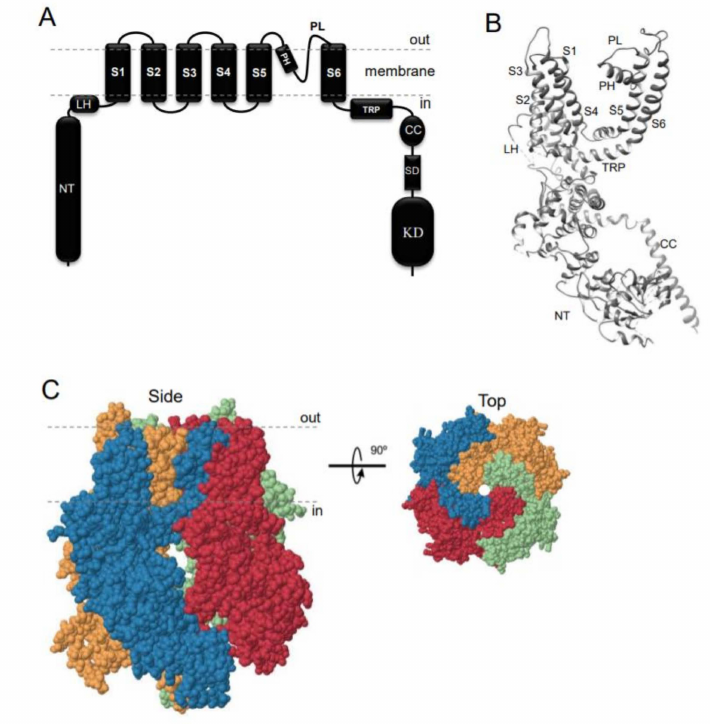
Figure 1. Domain topology and tetrameric assembly of the kinase-coupled channel TRPM7. ( A ) TRPM7 comprises a large cytosolic N-terminal domain (NT), a linker-helical domain (LH), six transmembrane helices (S1-S6), a pore-forming pore helix (PH) and loop (PL), a transient receptor potential domain (TRP), a coiled-coil domain (CC), a kinase substrate domain (SD) and a kinase domain (KD). ( B ) Ribbon diagram of a single TRPM7 channel subunit produced from 6BWD using UCSF Chimera (www.cgl.ucsf.edu). ( C ) Tetrameric TRPM7 channel complex (6BWD) Four channel subunits of TRPM7 are labeled by di ff erent colors and shown from the side and top